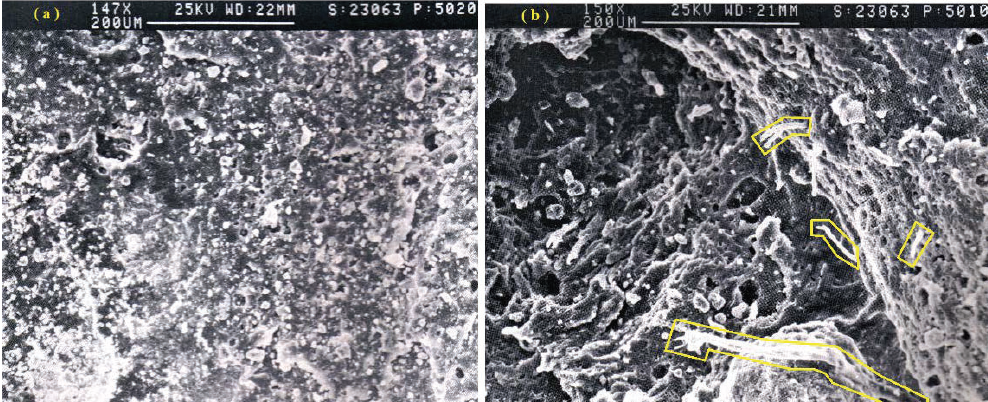
Figure 4. SEM images of rubber compounds. ( a ) Sample BC immediately after vulcanization; ( b ) sample CMPTD immediately after vulcanization. Yellow lines highlight fibers emerging from the